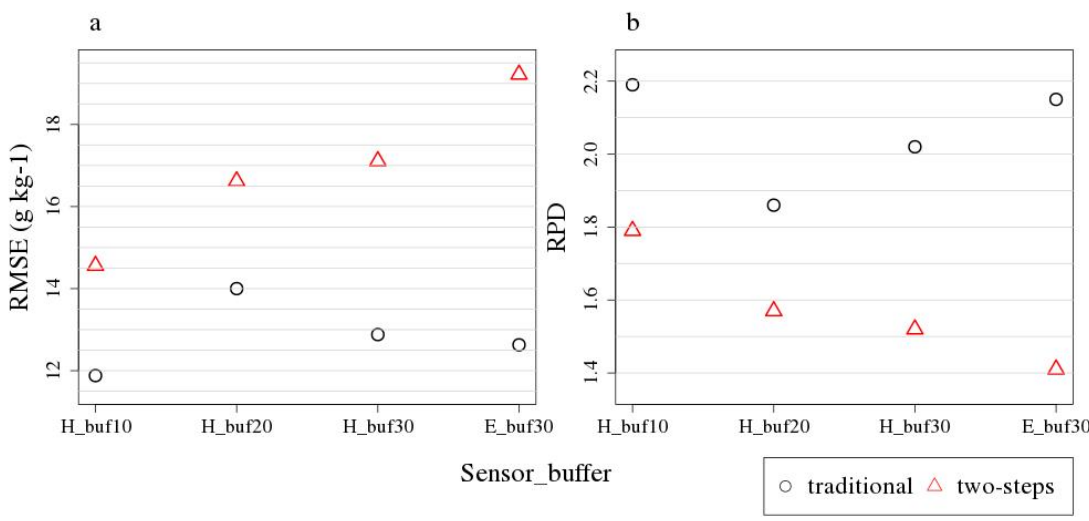
Figure 10. RMSE ( a ) and RPD ( b ) for HySpex (H_) and EnMAP (E_), for the traditional and the two-step approaches and different extraction buffer: buf10 = buffer of 10 m, buf20 = buffer of 20 m, buf30 = buffer of 30 m.